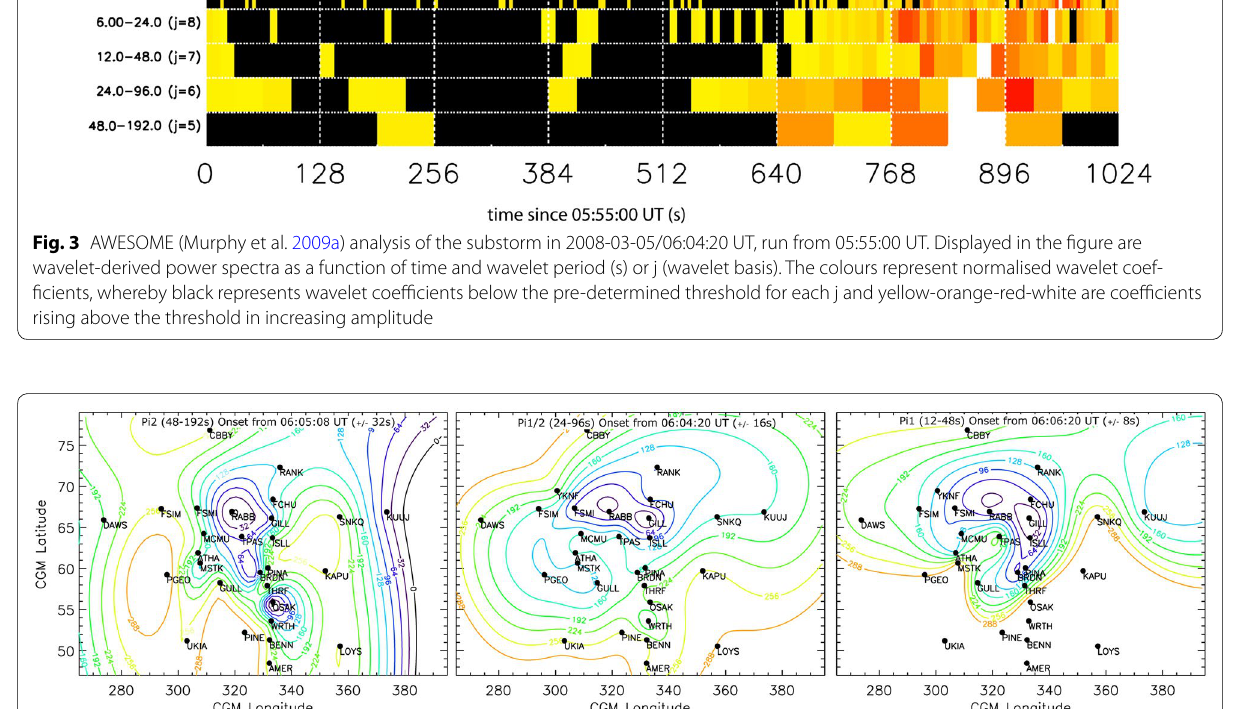
5 or 48–192 s, (centre) j 6 or 24–96 s, and (right) j 7 or 12–48 s period bands = = =